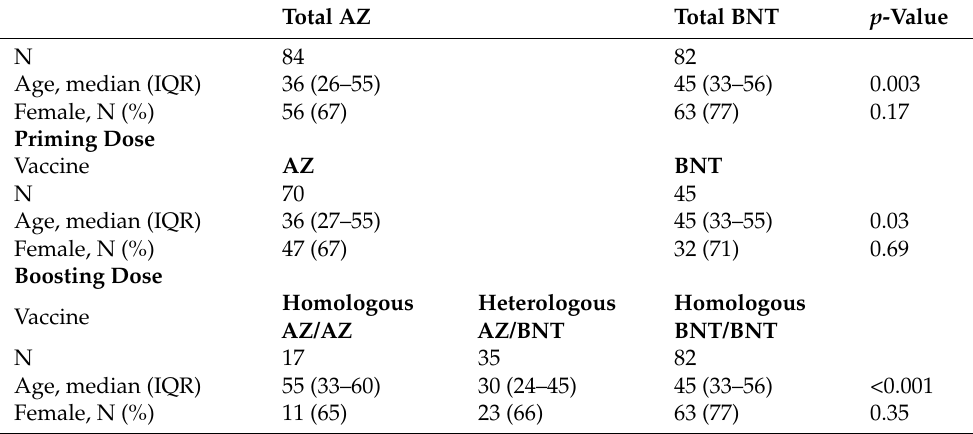
Table 1. Participants’ baseline characteristics. AZ, AstraZeneca; BNT, BioNTech; IQR, interquartile range; N,